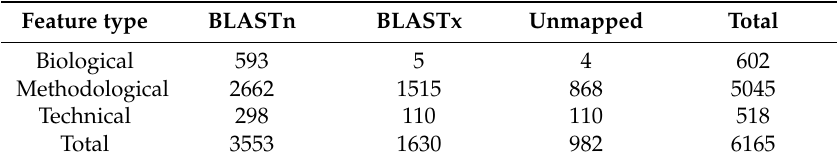
Table 1. Annotation of associations. The 6165 clusters were mapped using BLASTn and BLASTx. Rows describe the corresponding type of feature involved as the strongest association of each cluster.